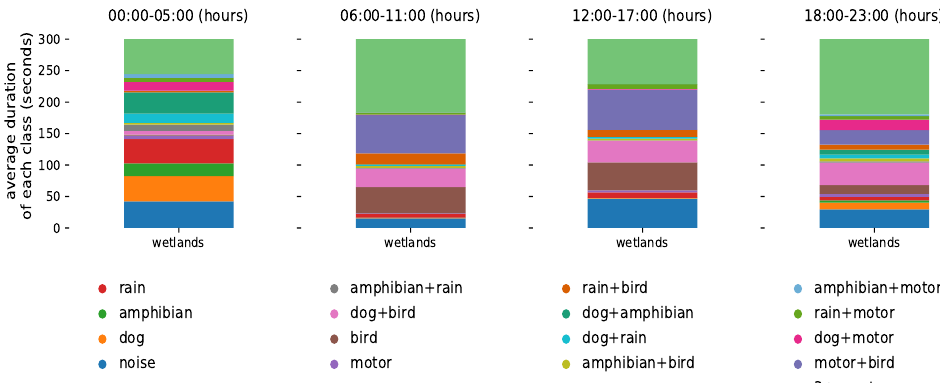
Figure 4. Global temporal evolution of the classes of all the datasets, average durations and quantities collected at the three urban wetlands during the ten days of